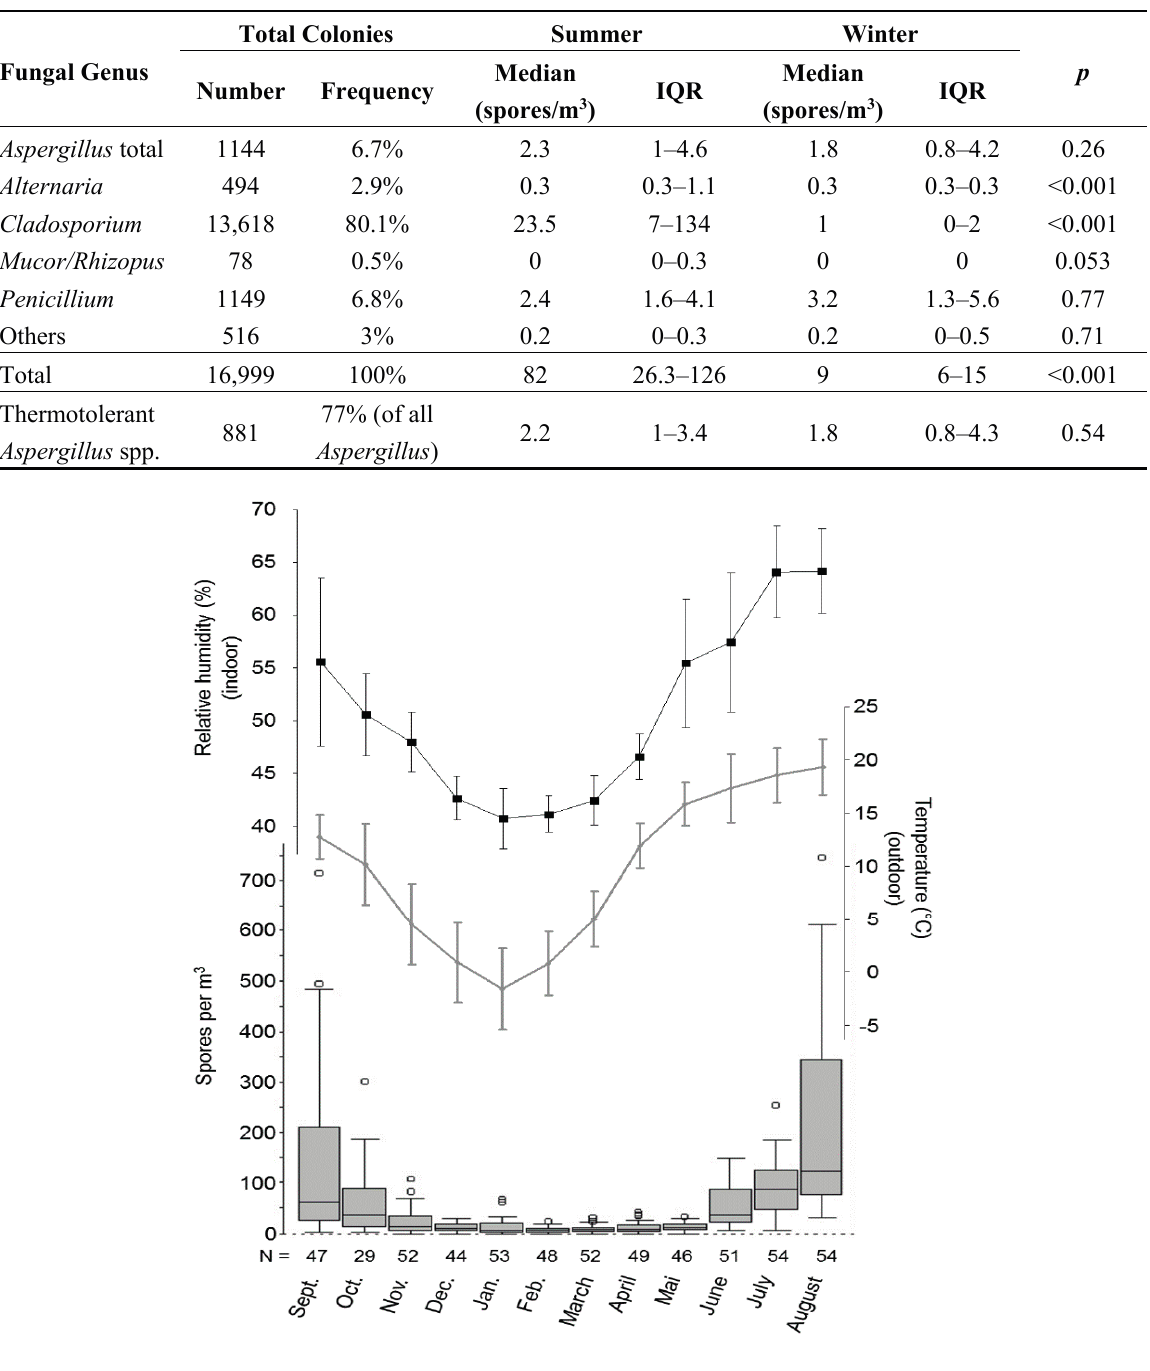
Figure 1. Dynamics of the monthly median of fungal spores concentrations, the outdoor mean temperatures and the indoor mean relative humidity ( N = number of Sabouraud Petri dishes analyzed, sampling twice a